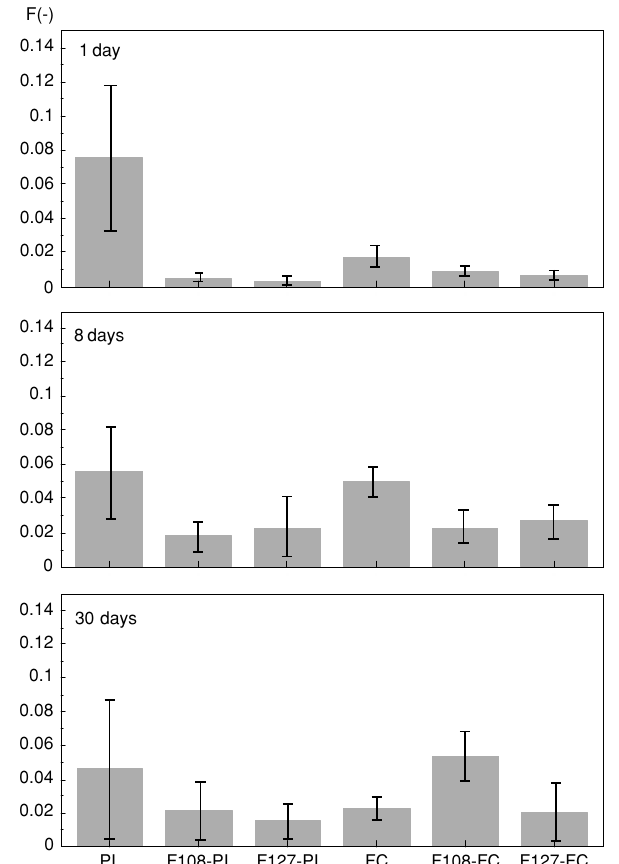
Figure 3 Quantified background adhesion fraction F (see “Quantification of background adhesion” under Methods) of neuronal tissue on six different background surfaces (neurophobic part) after 1, 8 and 30 days. Mean ± SD ( n = 6). PI: polyimide coating only; F108-PI: Synperonics F108 coating on top of PI layer; F127-PI: Synperonics F127 coating on top of PI layer; FC: fluorocarbon coating only; F108-FC: Synperonics F108 coating on top of FC layer; F127-FC: Synperonics F127 coating on top of FC layer.